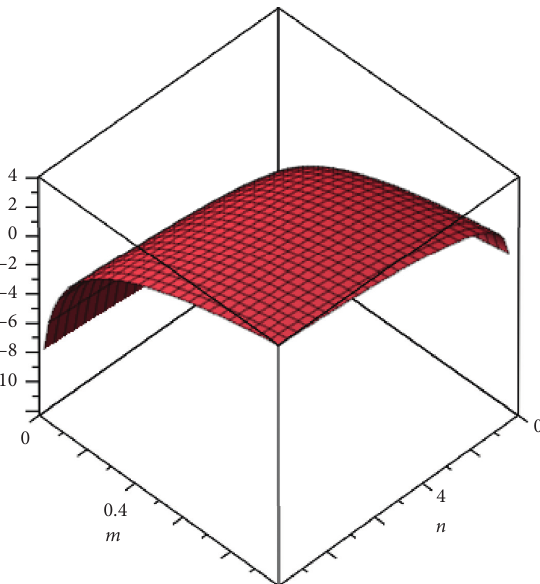
Figure 6: Plot of entropy of TUAC